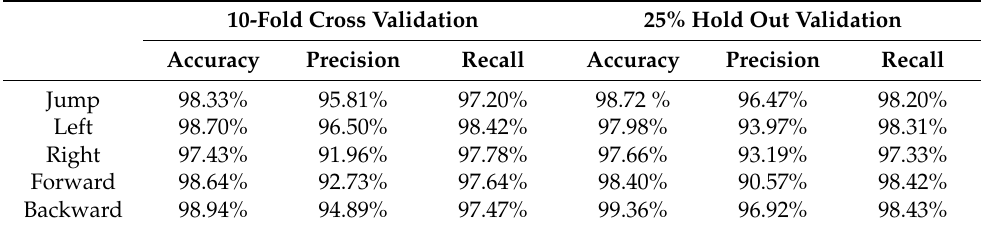
Table 5. Evaluation of kNN classifier.